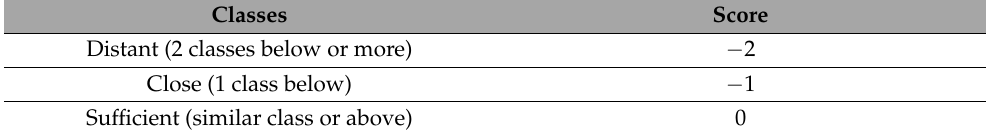
Table 7. SRe ds,pa —spatial resolution.